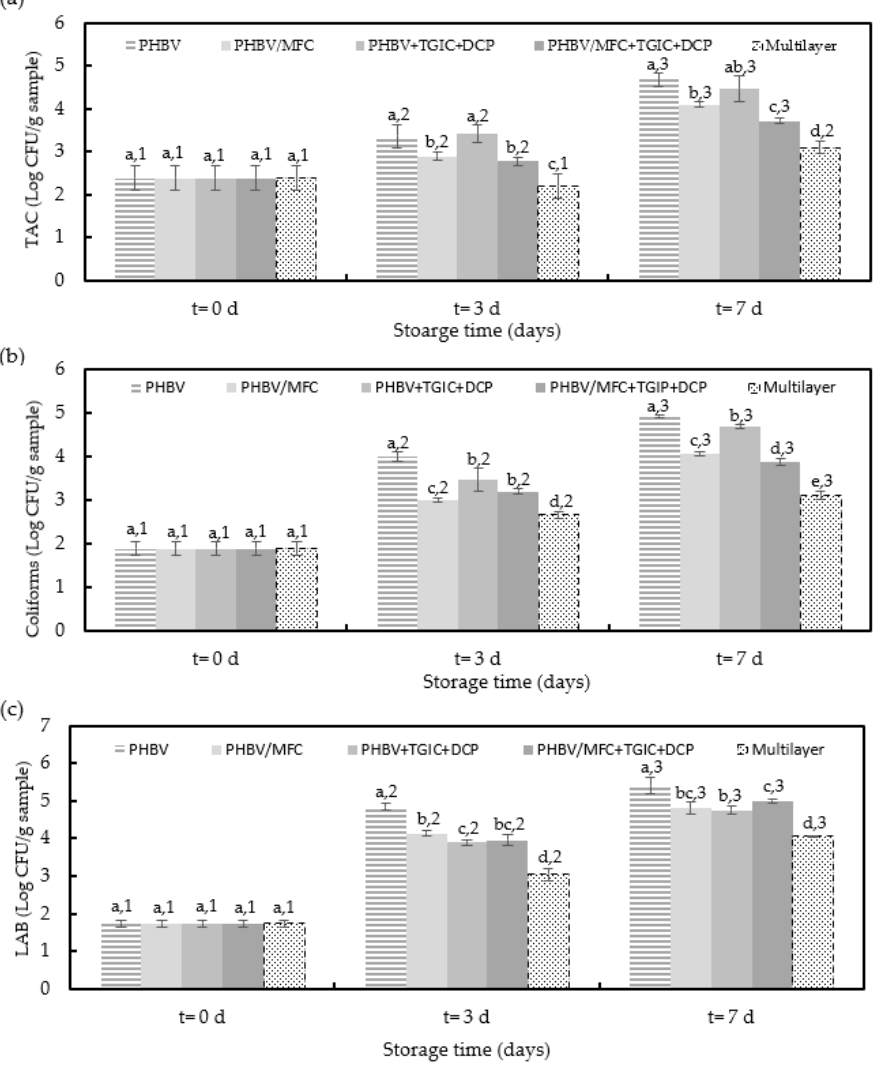
Figure 4. Total aerobic counts (TAC) ( a ), coliforms ( b ), and lactic acid bacteria (LAB) ( c ) of the cold-stored minced pork meat samples packaged in trays with the green composite lid films of poly(3-hydroxybutyrate- co -3-hydroxyvalerate) (PHBV) with microfibrillated cellulose (MFC) and compatibilized with triglycidyl isocyanurate (TGIC) and dicumyl peroxide (DCP) and the multilayer commercial film. Different superscripts (a–e) indicate significant differences among samples for the same storage time and different superscripts (1–3) indicate differences due to storage time for the same sample ( p < 0.05).